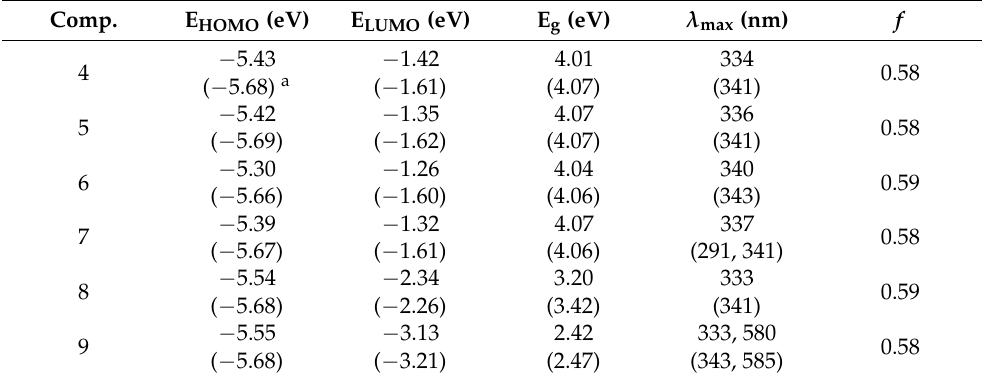
The data in brackets in H 2 O.